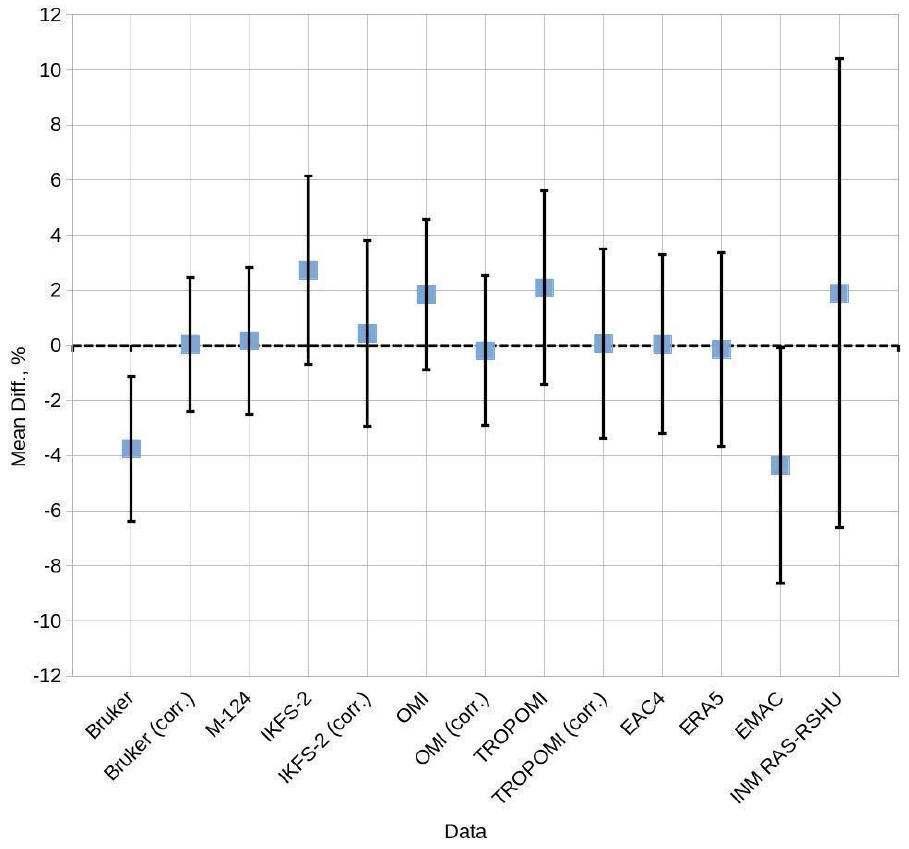
Figure 8. MDs (vertical axis) and SDDs (error bars) between the reference Dobson measurements and the TOC data of each other instrument/model near St. Petersburg for the time spans from 2009 to 2020; the values in % are given relatively to the Dobson mean; corr. = corrected data.